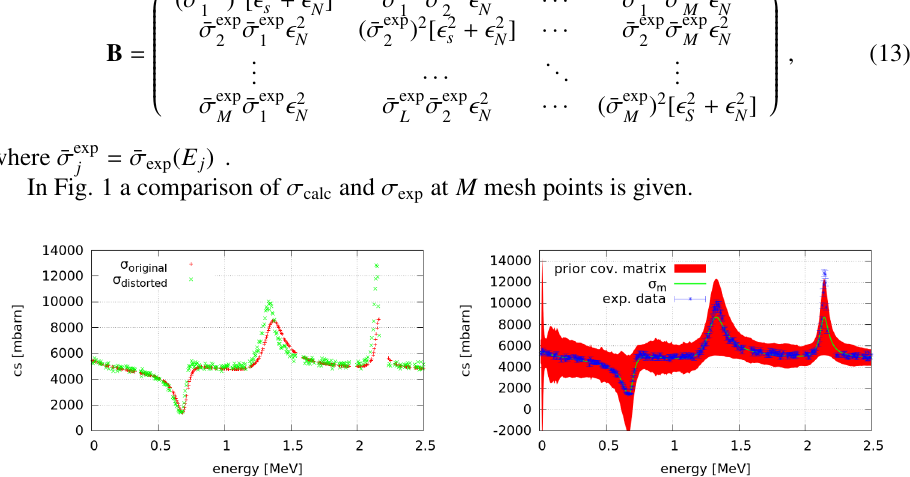
Figure 1. Left: Comparison of original and distorted data with α d = 7 × 10 − 6 . Right: schematic experimental data and best parameter cross section σ M ( E ) with a -priori variance